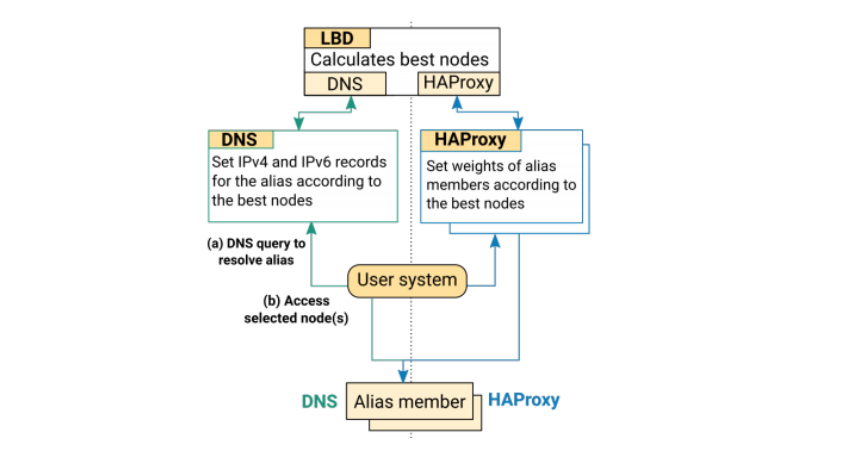
Figure 4: Component-reuse for the implementation of the DNS & HAProxy